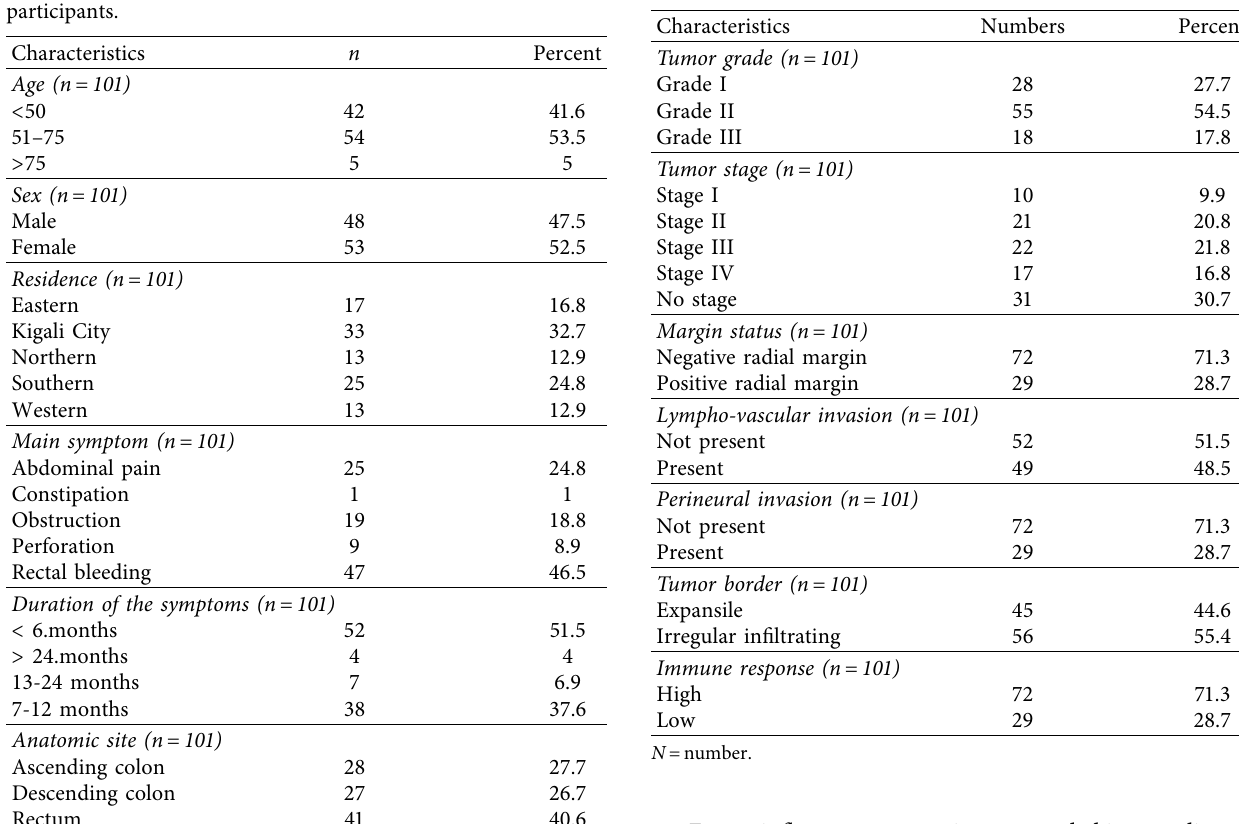
Table 3: Pathologic prognostic determinants of colorectal